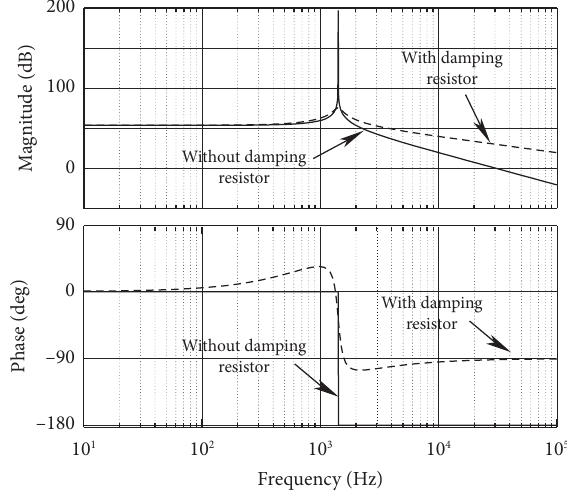
Figure 5: Bode diagram of the LCL grid-connected flter.